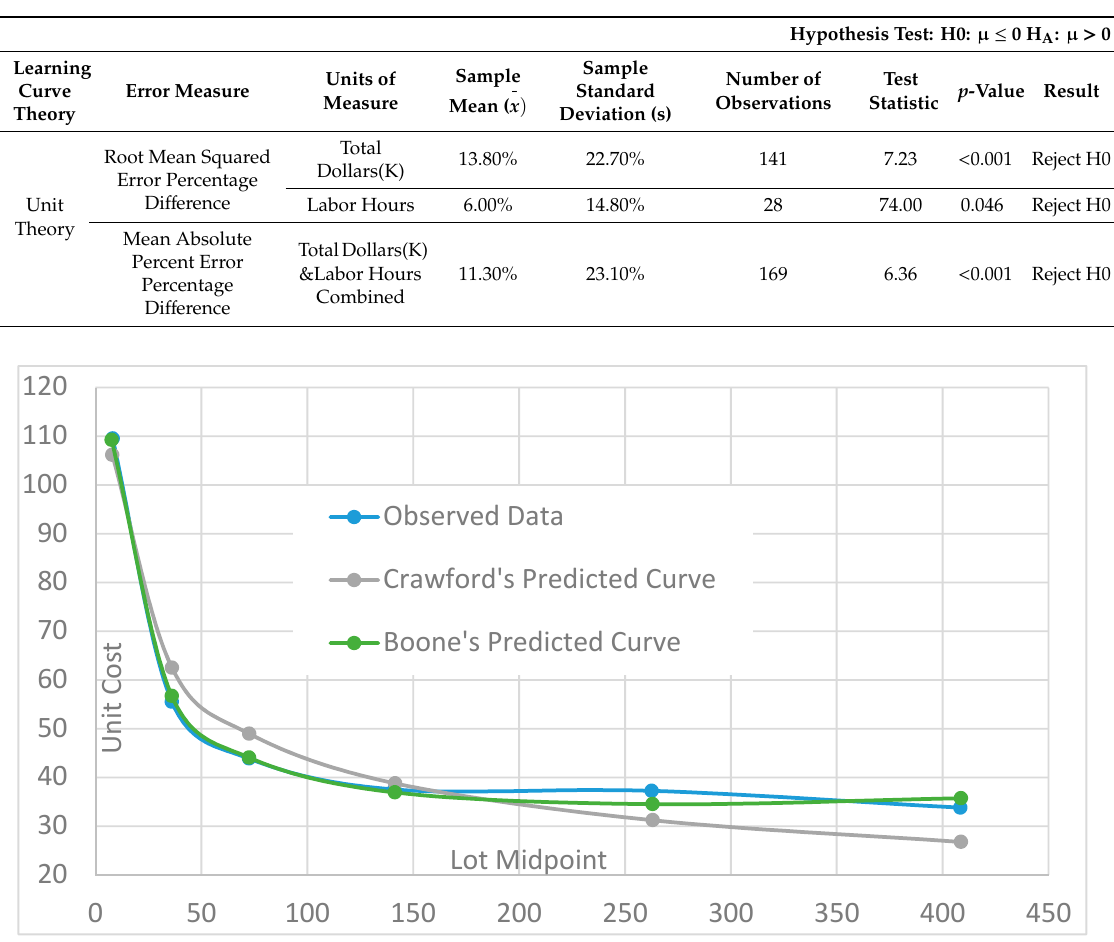
Figure 5. Comparison of Program 1 PME Air Vehicle.